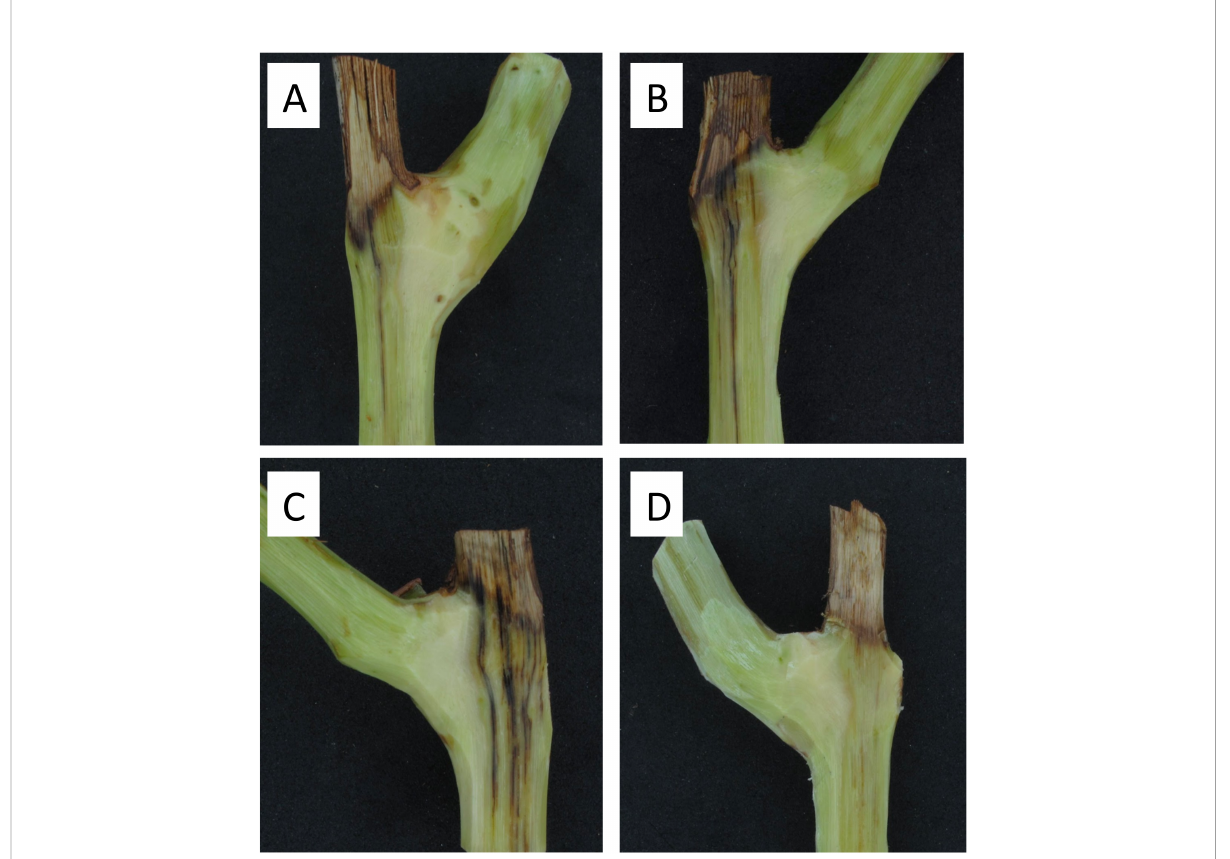
FIGURE 4 Vascular discoloration caused by arti fi cial inoculation of a conidial suspension (10 5 conidia/mL) of Phaeomoniella chlamydospora (Pach-3) on pruning wounds of different ages of spurs cv. Cabernet Sauvignon after eight months in Central Chile. Vascular discoloration on spur inoculated 15 days after pruning in a vineyard located in Buin (A) . Necrotic lesion on spur inoculated 1 day after pruning in a vineyard located in Buin (B) . Necrotic lesion on spur inoculated 1 day after pruning in a vineyard located in Nancagua (C) . Healthy spur of non-inoculated pruning wound in natural conditions of commercial vineyard located in Nancagua (D) .